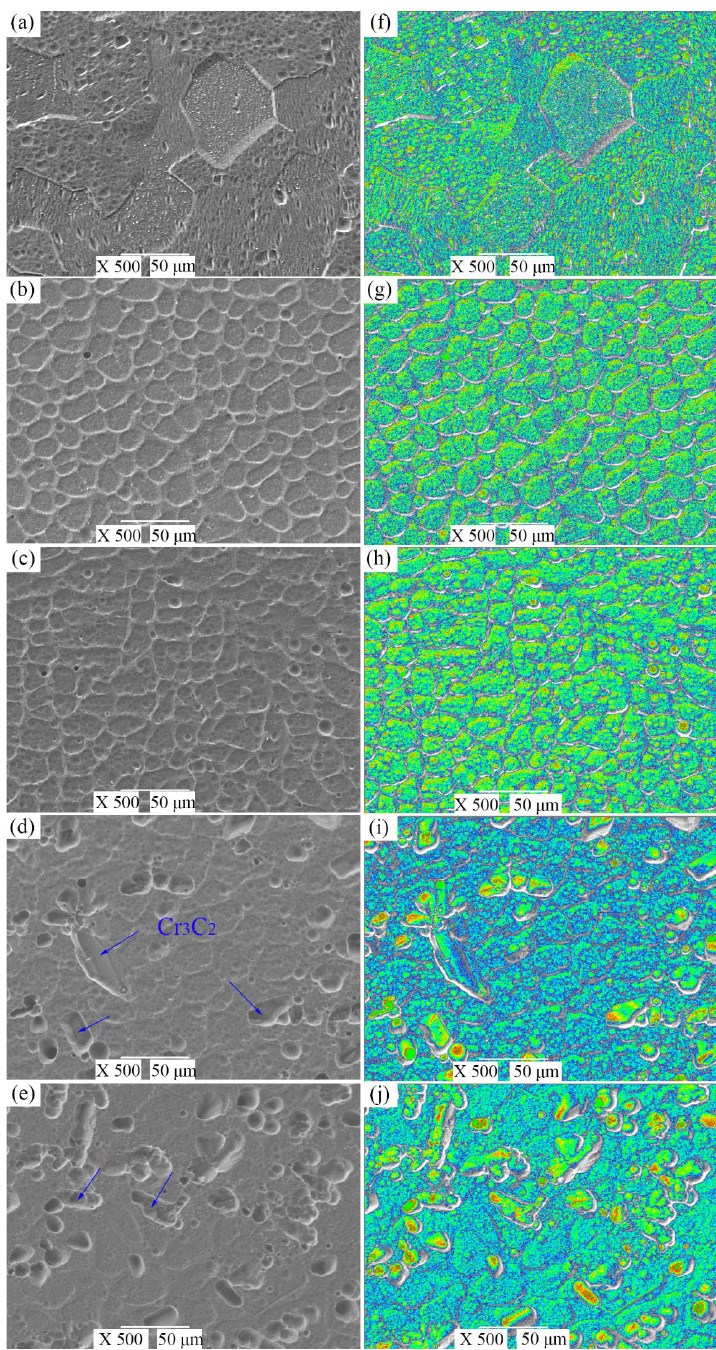
Figure 3. SEM morphologies and dyed results of Cr 3 C 2 particle-reinforced Al matrix composite: ( a , f ) pure Al, ( b , g ) 1.0 wt. % Cr 3 C 2p /Al composite, ( c , h ) 2.0 wt. % Cr 3 C 2p /Al composite, ( d , i ) 3.0 wt. % Cr 3 C 2p /Al composite, and ( e , j ) 4.0 wt. % Cr 3 C 2p /Al